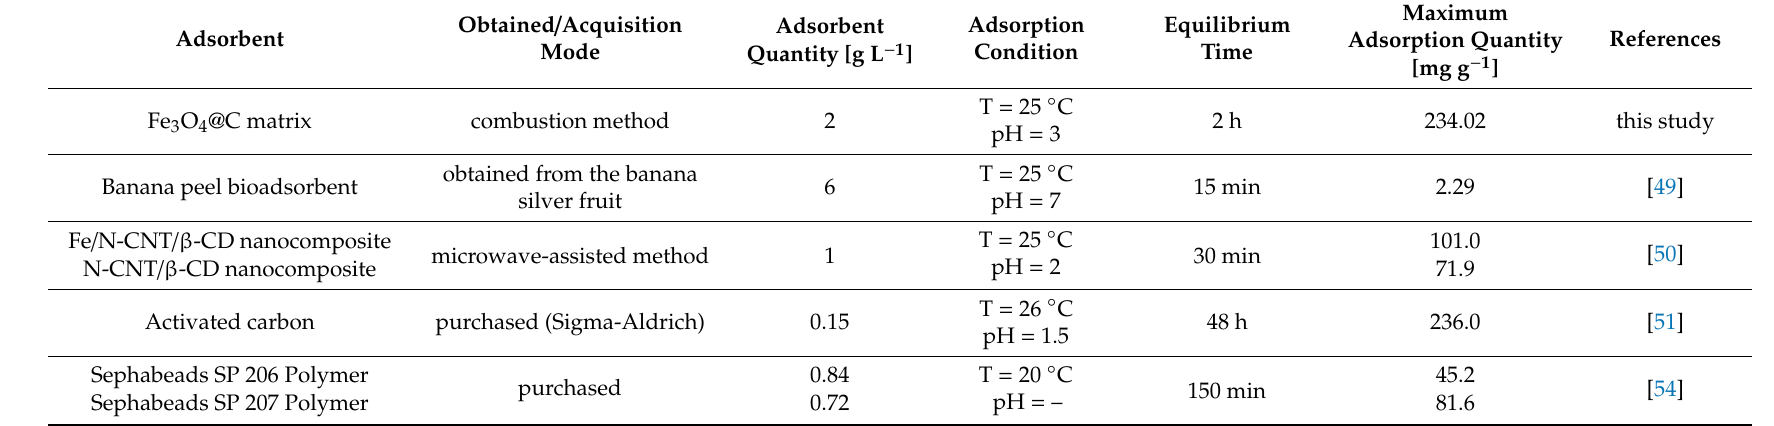
Table 5. Comparison of the removal e ffi ciency of acetylsalicylic acid using di ff erent